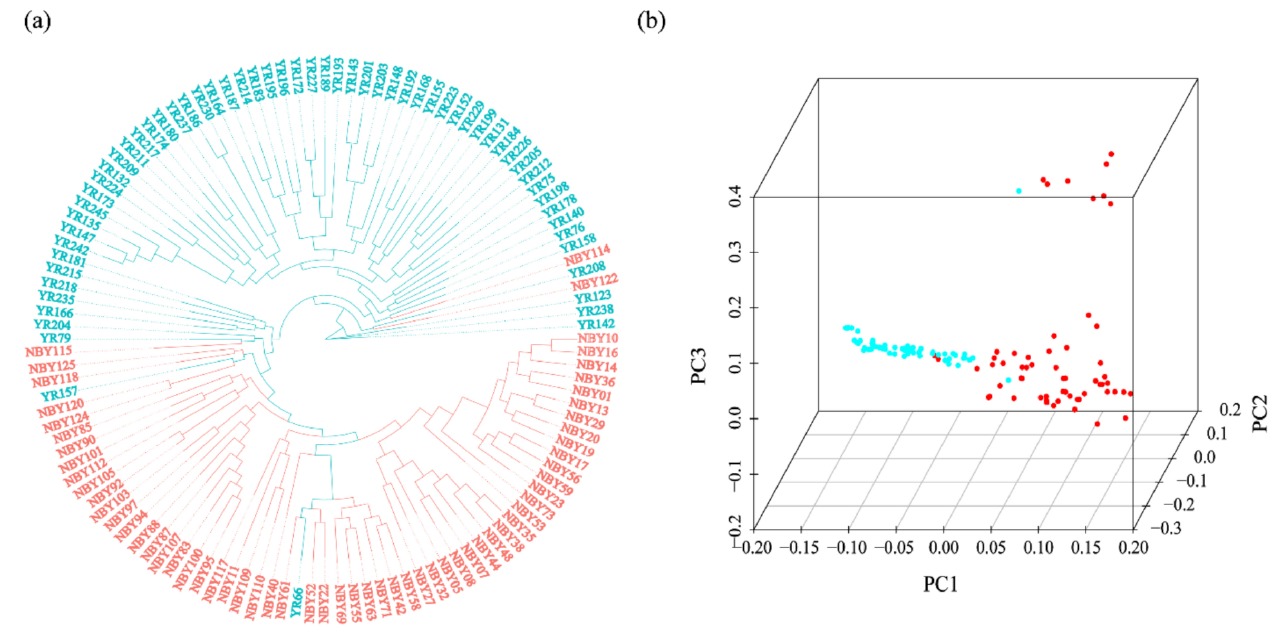
Figure 1. The phylogenetic tree ( a ) and principal component analysis ( b ) of Yunling goat (YR) and Nubian goat (NBY) were inferred from the RAD-seq dataset. (The blue and red colors represent Yunling goats and Nubian goats, respectively.).